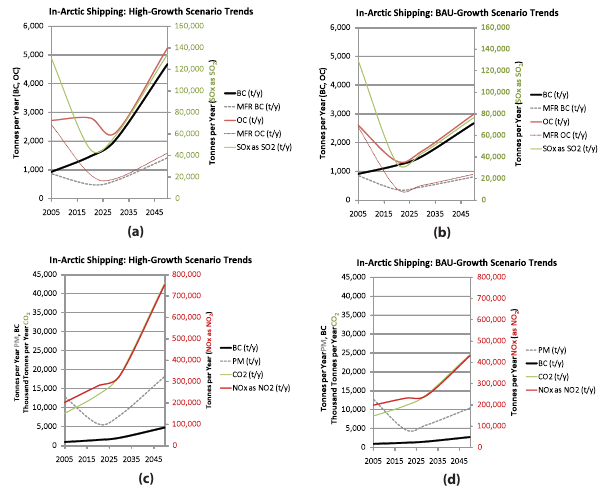
Fig. 3. Comparison of in-Arctic trends for black carbon, organic carbon, and SO x emissions under (a) high growth and (b) BAU sce- narios. Also shown are the comparison of black carbon, particulate matter, CO 2 and NO x under (c) high growth and (d) BAU